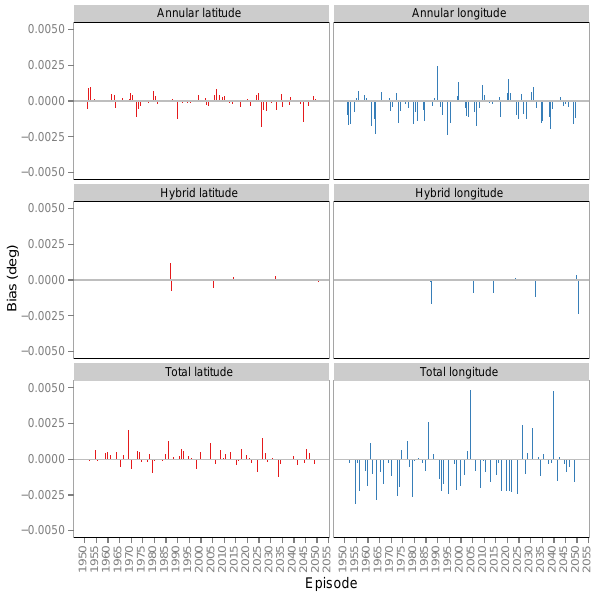
Figure 1. Bias in the eclipse’s track computed by WRF-ARW in comparison to the NASA